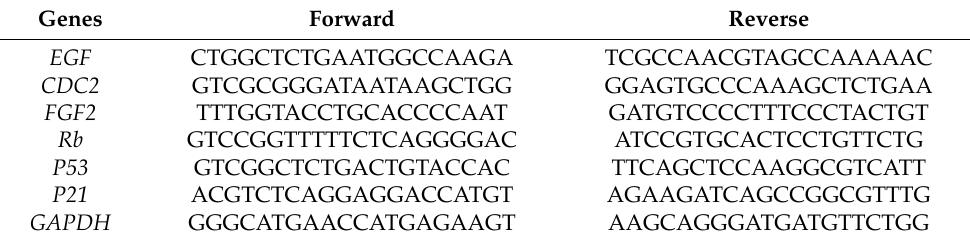
Table 4. Primers used for gene expression analysis through Real-Time